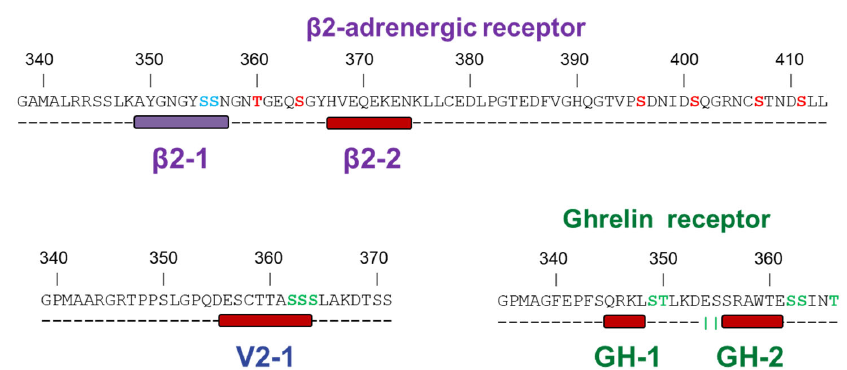
Figure 4. The C-terminal regions of β 2AR-Cter (purple), GHSR-Cter (green), and V2R-Cter (blue) revealed different transient secondary structures, which could be involved in arrestin binding . GRK2 (red) and GRK6 (blue) phosphorylated sites according to [9] for β 2AR, [72] for GHSR, and [73] for V2R are indicated in the sequence. Secondary structures obtained by NMR secondary structure consensus are indicated under the sequence, according to Figure 3. V2R ‐ Cter, GHSR ‐ Cter, and β 2AR ‐ Cter are variable in length and in sequence